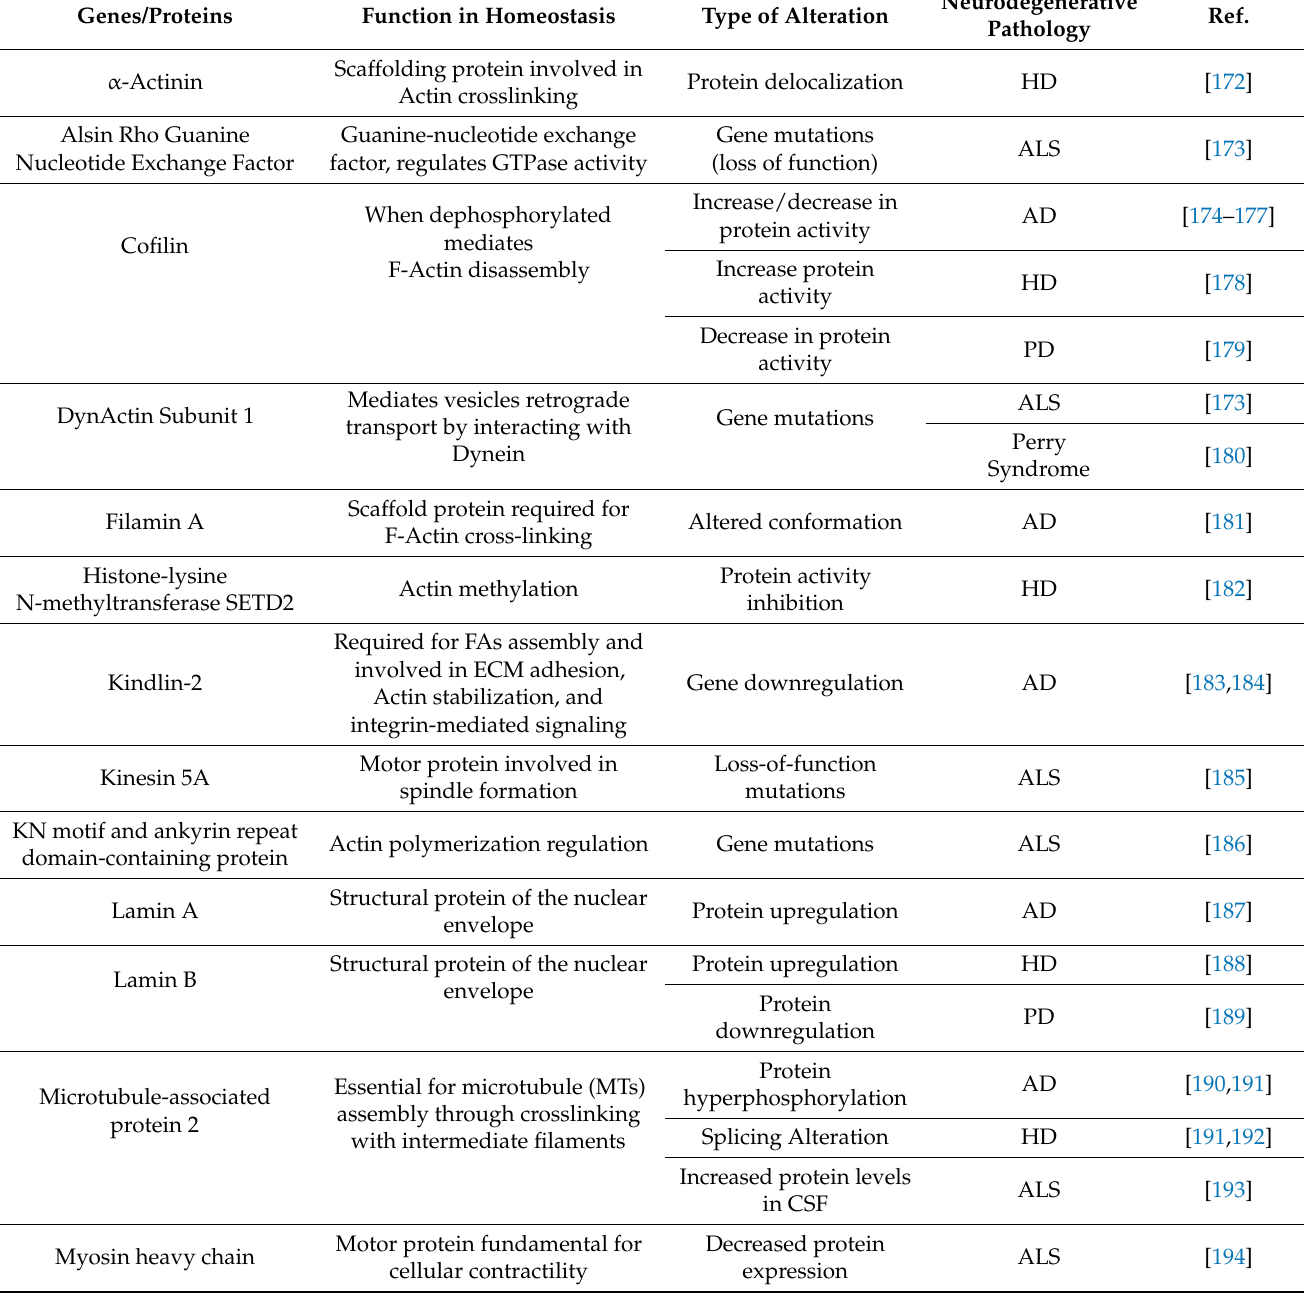
Table 2. Mechanosensing/mechanotransduction related genes and proteins altered in neurodegener- ative